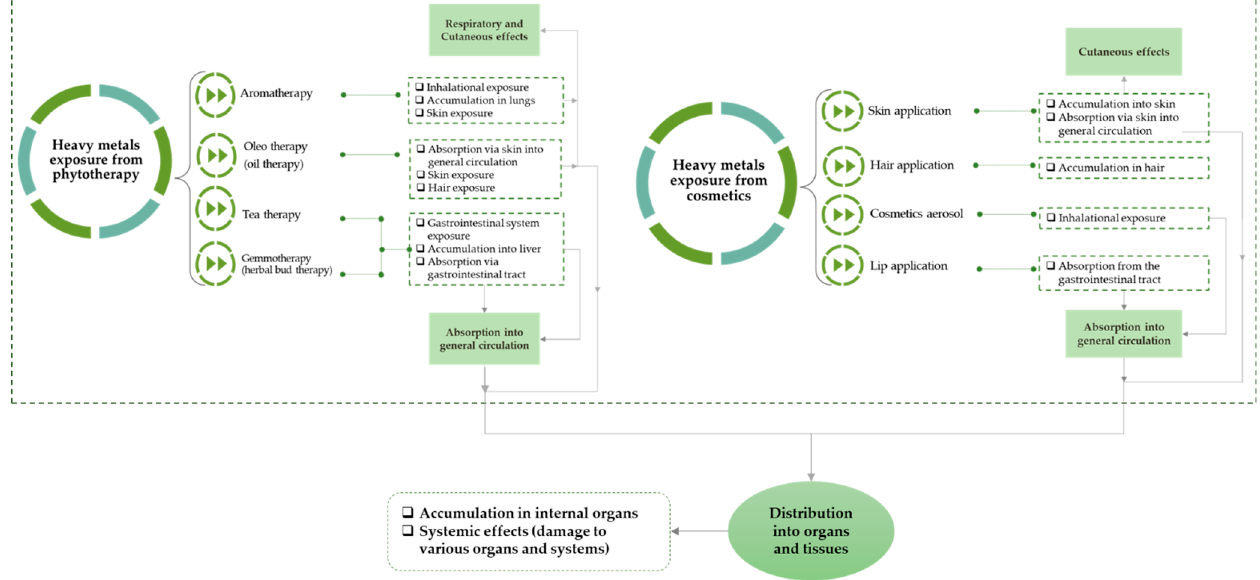
Figure 3. Human exposure to heavy metals from phytotherapy and